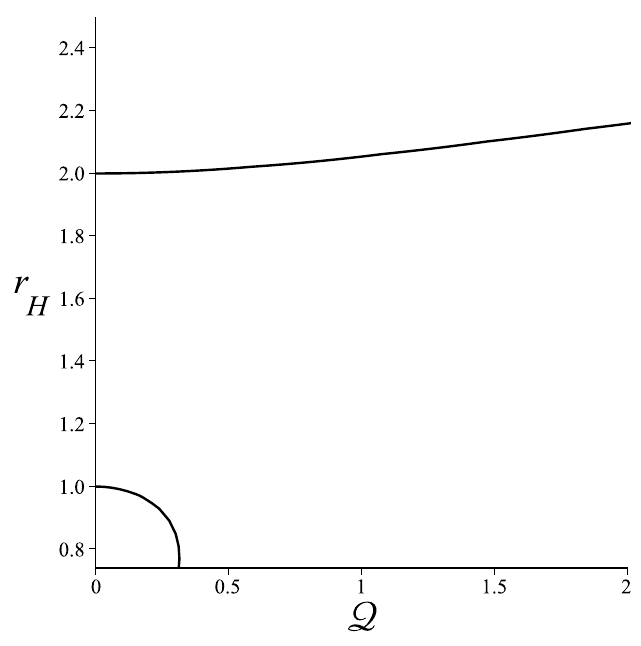
Figure 3 . Radial coordinate at horizon for AdS 5 -Reissner-Nordström black holes, as a function of the charge. (Parameters, including the temperature, fixed in units with L = 1 , at values chosen for illustrative clarity.) The corresponding “large” AdS 5 -Schwarzschild black hole has r H = 2 in these